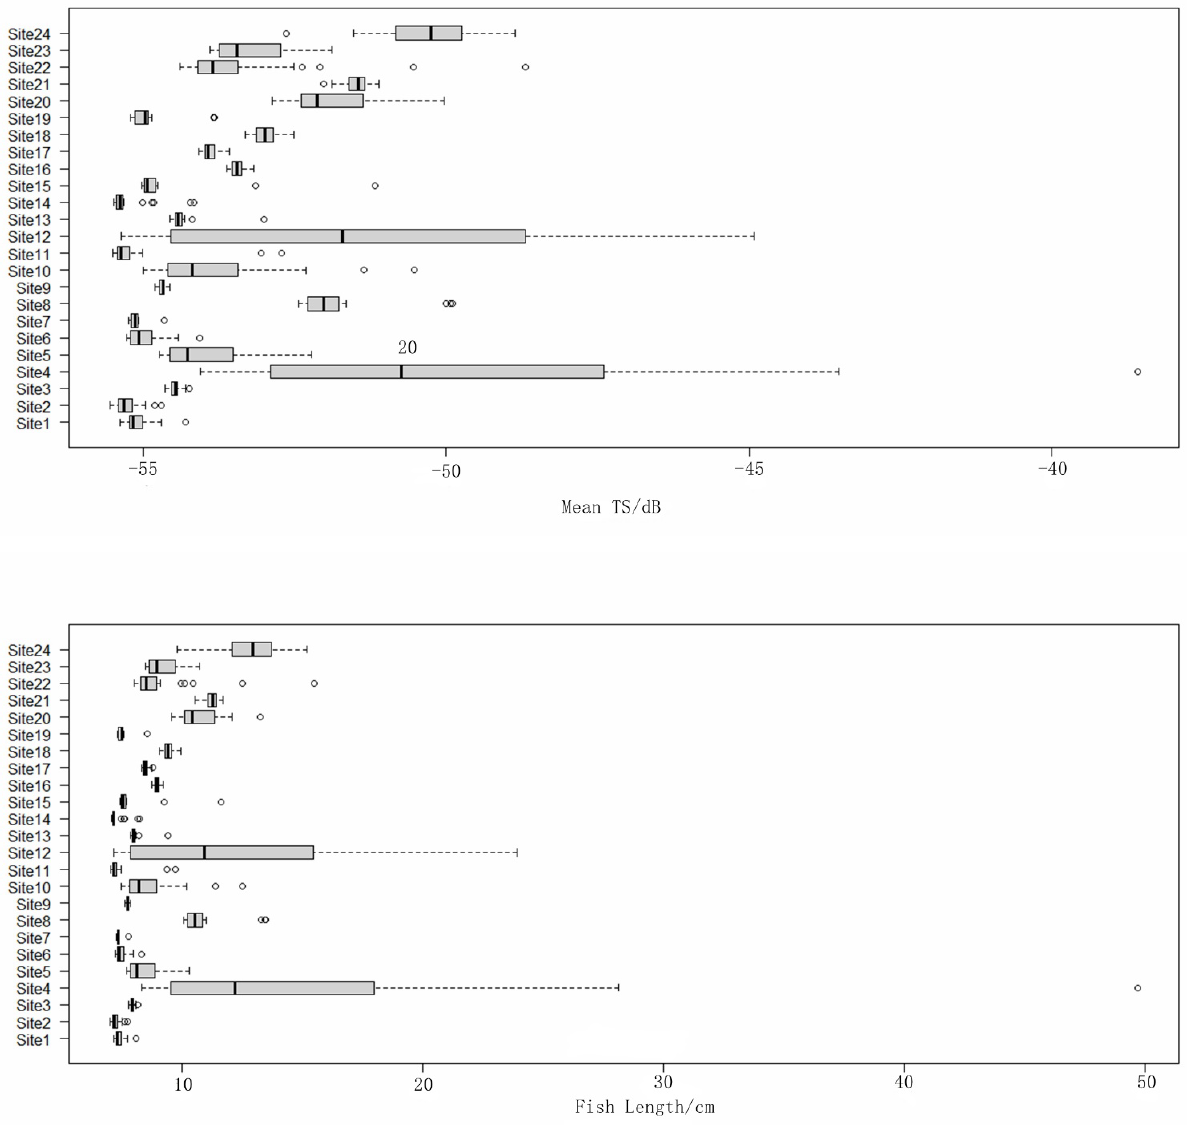
Figure 3. The mean TS values in decibel and the mean fish size derived using Love’s equation (1971) at survey sites. Box plots show median values (solid horizontal line), and the lower and upper ends of the box are the 25 and 75% quartiles, respectively. The whiskers indicate 1.5 times the interquartile range, and points beyond this range are shown by empty circles.